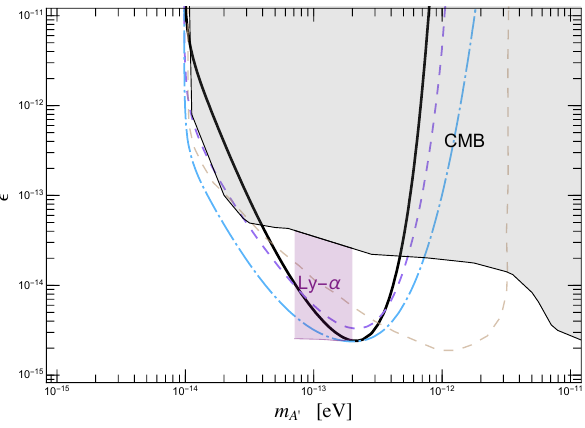
Figure 12 . Our result from (cid:12)gure 4 obtained with eq. (3.3) using T k = 10 4 K (black solid), or using the adiabatic temperature of the IGM (neglecting the heating induced during reionization, dashed purple). The result is also compared with the bound that would be obtained if we neglect the sensitivity function, i.e. S ((cid:1) b ; z ) = 1 (blue dot-dashed). A comparison is made to the constraint obtained by [22] (light brown, dashed). show the implications of neglecting the sensitivity function ( i.e. taking S ((cid:1) dot dashed). We compare to the bound derived in ref. [22]. We (cid:12)nd strong di(cid:11)erences in the constraints derived at low masses when varying the Jeans scale between 10 kpc